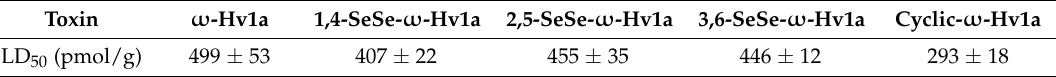
Table 2. LD 50 values for injection of Hv1a and analogs into sheep blowflies.